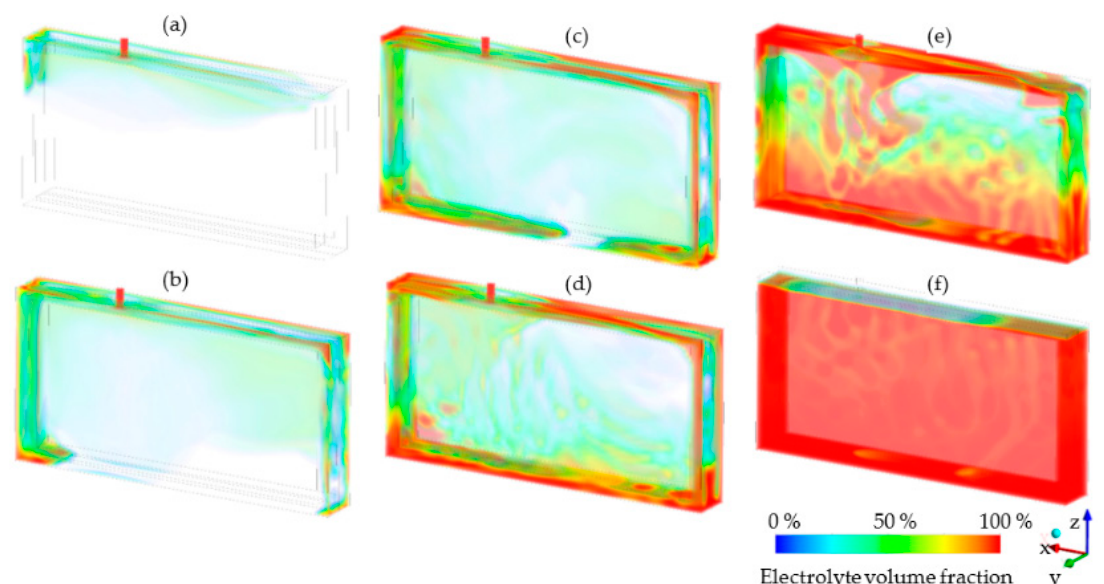
Figure 3. Results of the macro simulation showing the electrolyte flow through the cell after dosing during time steps ( a ) 0.05 s, ( b ) 0.2 s, ( c ) 0.4 s, ( d ) 0.6 s, ( e ) 1 s and ( f ) 15 s of dosing time. The initial pressure in the void volume ( p init = 50 mbar) and dosing pressure at the cell inlet ( p inlet = 300 mbar) generated the pressure difference ( Δ p = 250 mbar) for the electrolyte dosing. The temperature of the cell and of the electrolyte were set to 25 °C.